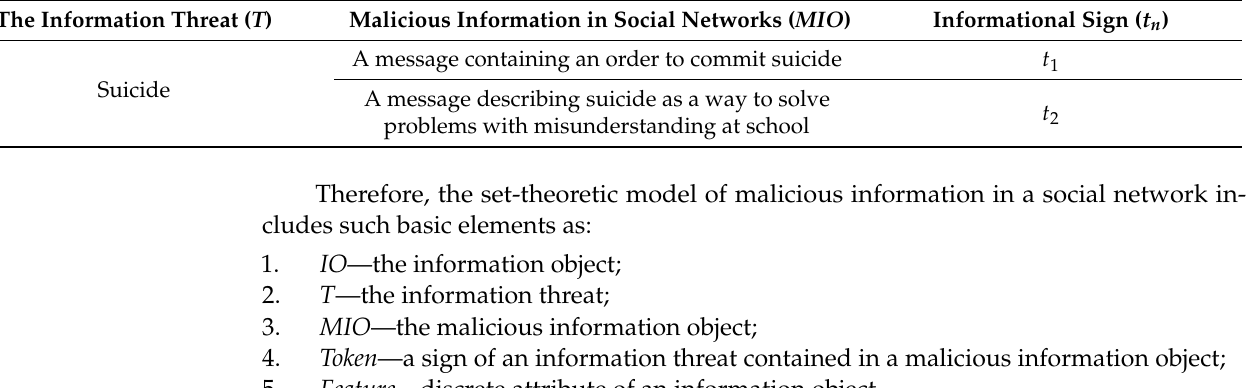
Table 1. Information and feature table of malicious